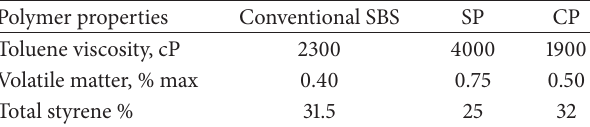
Table 1: Technical data of the two